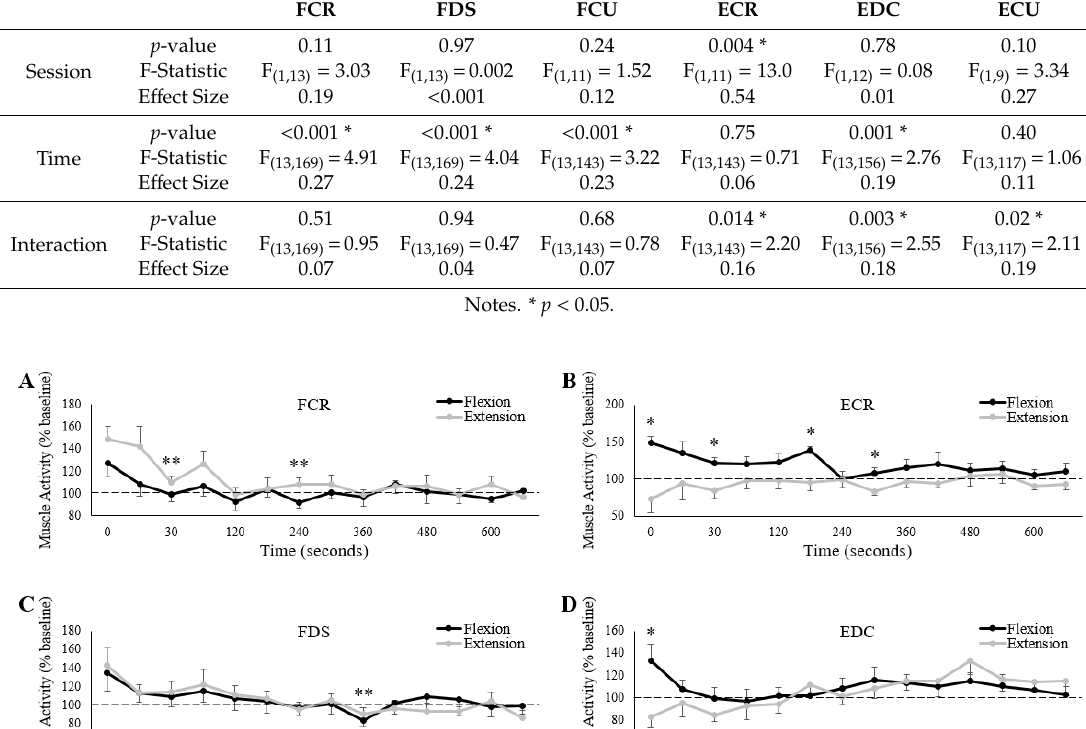
Table 2. Results from two-way repeated measures ANOVAs performed on pre-stimulus muscle activity normalized to baseline.